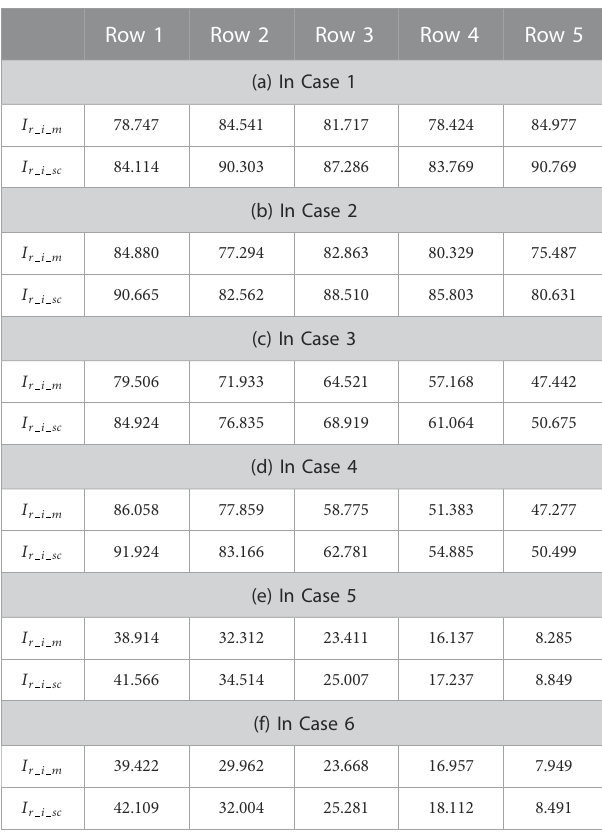
TABLE 4 Current values (units: